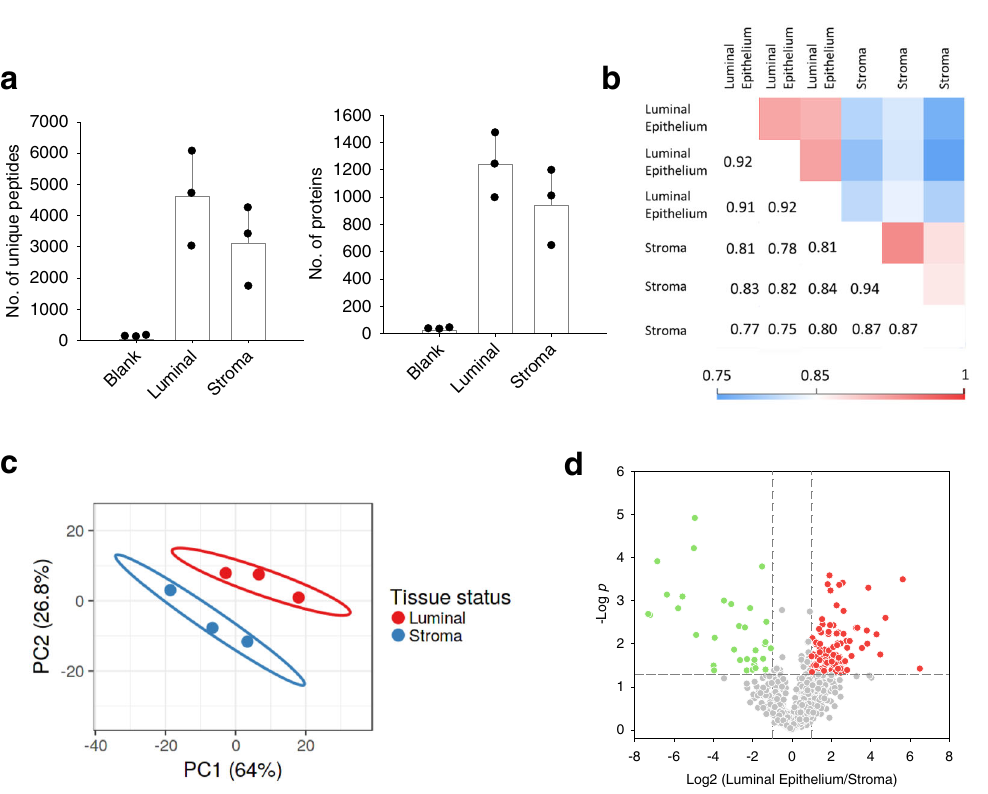
Fig. 2 SOP-MS analysis of LCM-dissected mouse uterine tissue. a Number of unique peptides and protein groups identi fi ed by the MS/MS spectra only (without MBR) from three biological replicates per cell type (luminal epithelial and stroma) and three blanks. The LCM tissue size: 100 µ m (length) × 100 µ m (width) × 10 µ m (thickness). Each LCM-dissected tissue sample is close to ~20 cells. b Pairwise correlation of log 10 -transformed protein LFQ intensities between any two replicates. Pearson correlation coef fi cients were color coded as shown on the scale at the bottom. c Unsupervised PCA analysis based on label-free quanti fi cation of proteins expressed in luminal epithelial and stroma cells. d Volcano plot of proteins differentially expressed between the two cell types from three biological replicates per cell